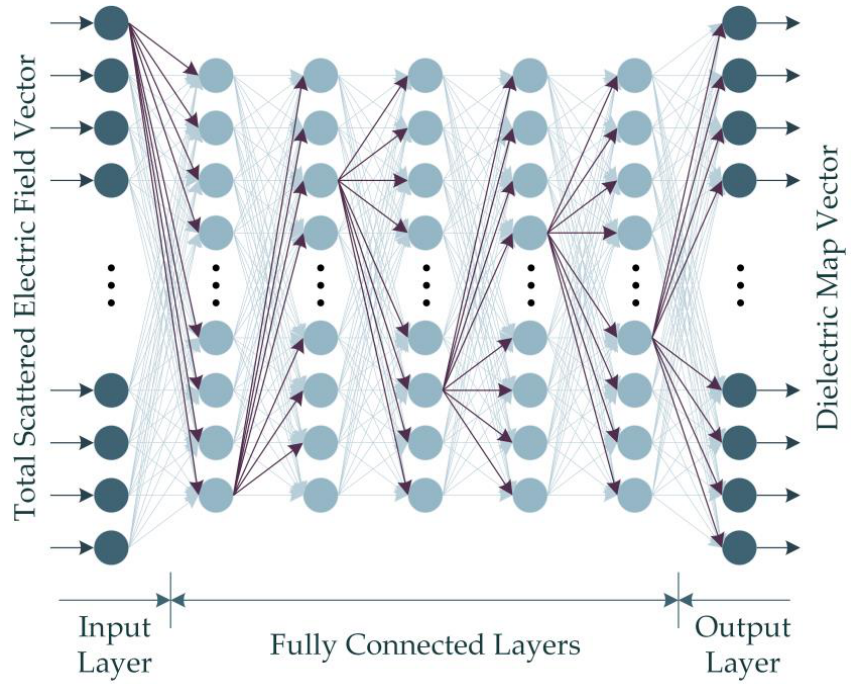
Figure 4. The proposed RV-DNN model for microwave medical imaging.